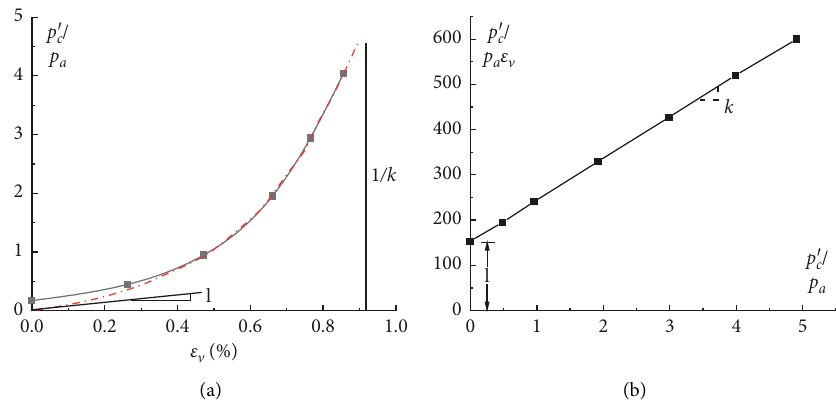
Figure 4: The experimental data for the p